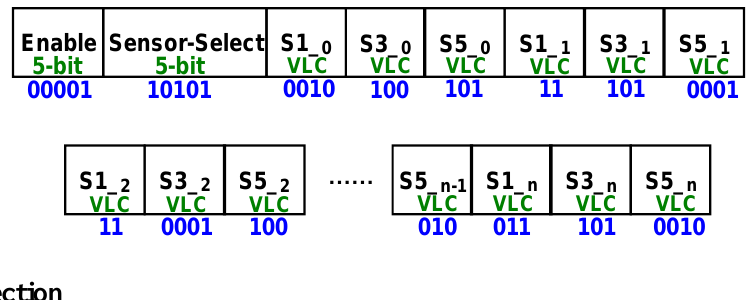
Figure 9. The data stream of the sensor